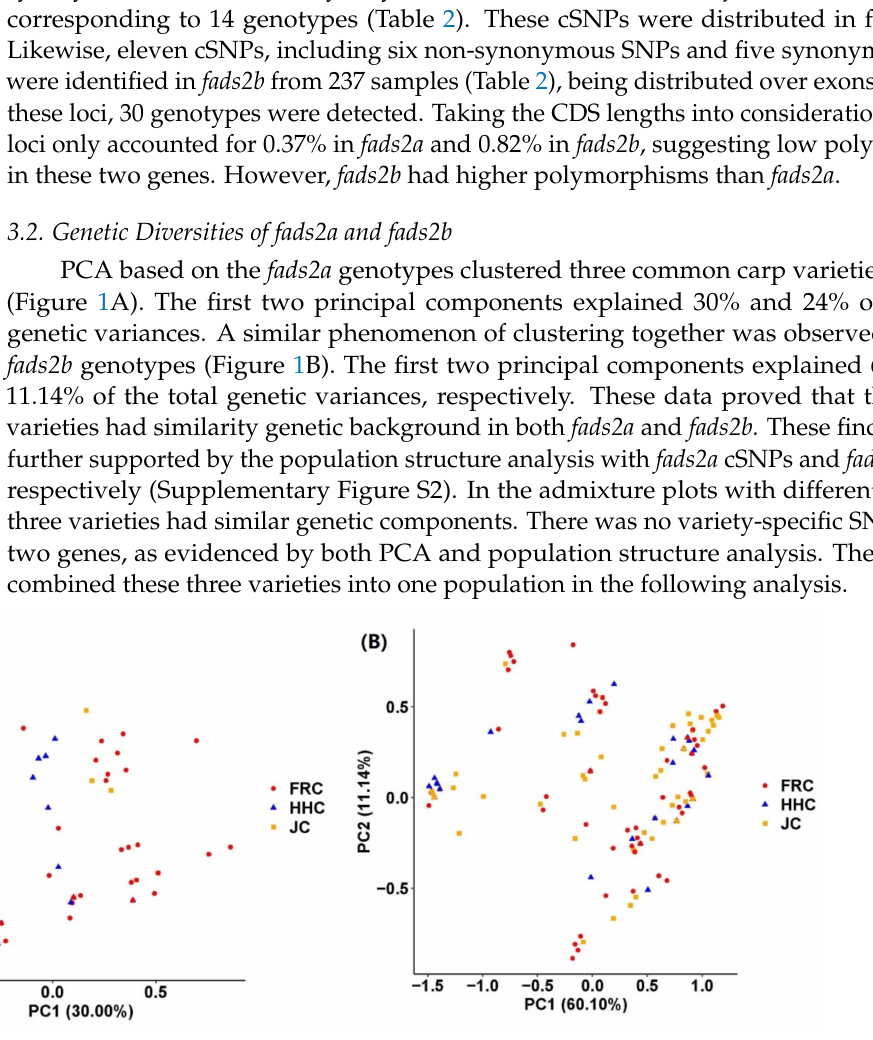
Figure 1. The PCA plots clustering three common carp varieties with the genotypes of fads2a ( A ) and fads2b ( B